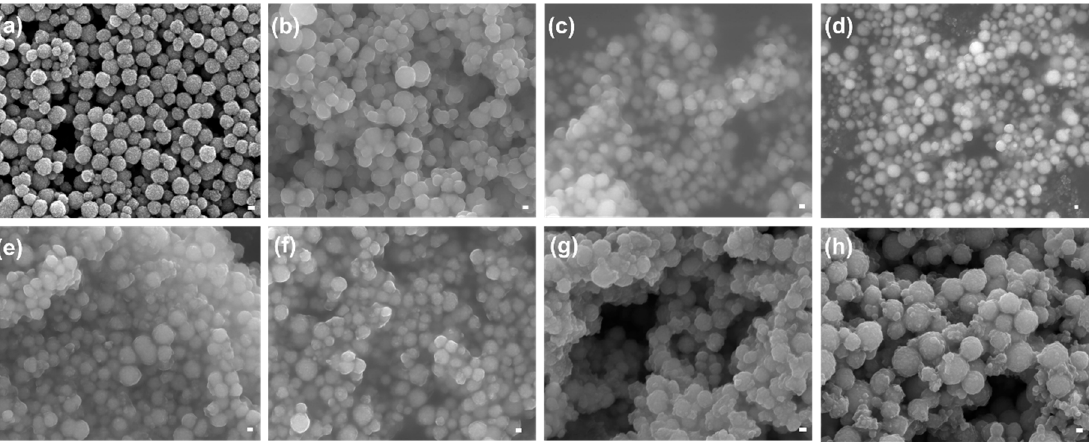
Figure 5. FE-SEM images of ( a ) Fe 3 O 4 , ( b ) Fe 3 O 4 @APTMS, ( c ) Fe 3 O 4 @APTMS-GA, ( d ) Fe 3 O 4 @APTMS-GA-acrylate, ( e ) PCIMPs 107–116 , ( f ) PCIMPs 145–155 , ( g ) PCIMPs 169–178 , and ( h ) PCIMPs 233–245+G (Scale bar: 100 nm).